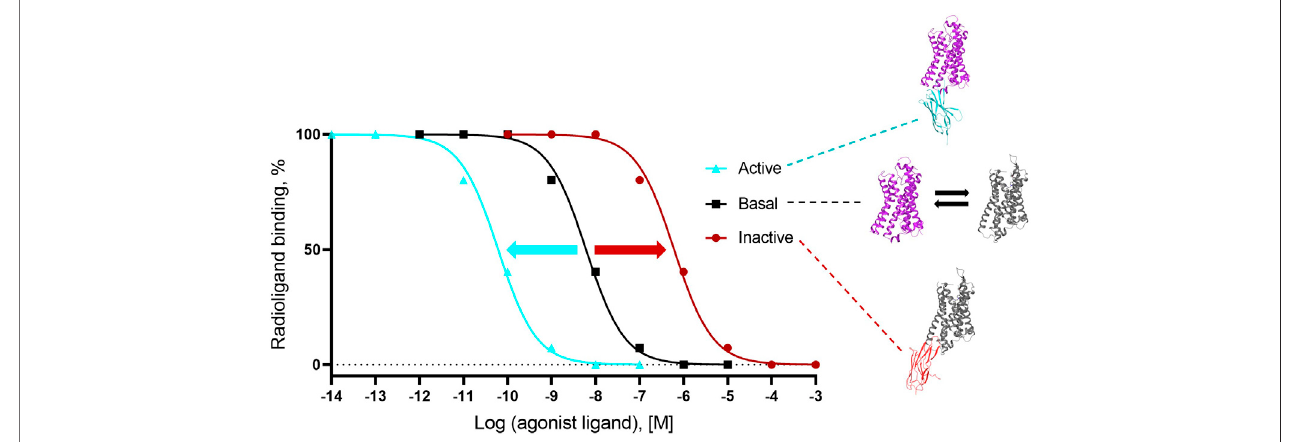
FIGURE3 | Gold standard assay to con fi rm conformer sensitivity ofVHHs (illustration of the potential impact ofa ConfoBody). The assayuses aneutral antagonist radioligand that is agnostic for the distinct receptor conformers (i.e., shows an identical af fi nity for all conformers) and a cold agonist competitor. Following dose- dependent competition with a cold agonist in the presence of excess amounts of the conformer-stabilizing VHH, IC 50 values of the cold agonist can be calculated. A ConfoBody that stabilizes the active state receptor conformer will increase, similar to the G protein (not shown), the af fi nity of the competing cold agonist ligand for the GPCR (i.e., reduces the IC 50 of the agonist for the receptor) compared to the af fi nity of the agonist for the basal conformer (absence of Cb or presence of irrelevant VHH).Incontrast,aCbthatstabilizestheinactivestatereceptorconformerwilldecrease theaf fi nityofthecompetingagonistligandfortheGPCR(i.e.,increasestheIC 50 of the agonist for the GPCR) compared to the af fi nity of the agonist for the basal conformer. A Cb that causes a signi fi cant leftward or rightward shift of the curve compared to the curve obtained with the basal receptor conformation is either an active state- or inactive state-stabilizing, Type I or II Cb,